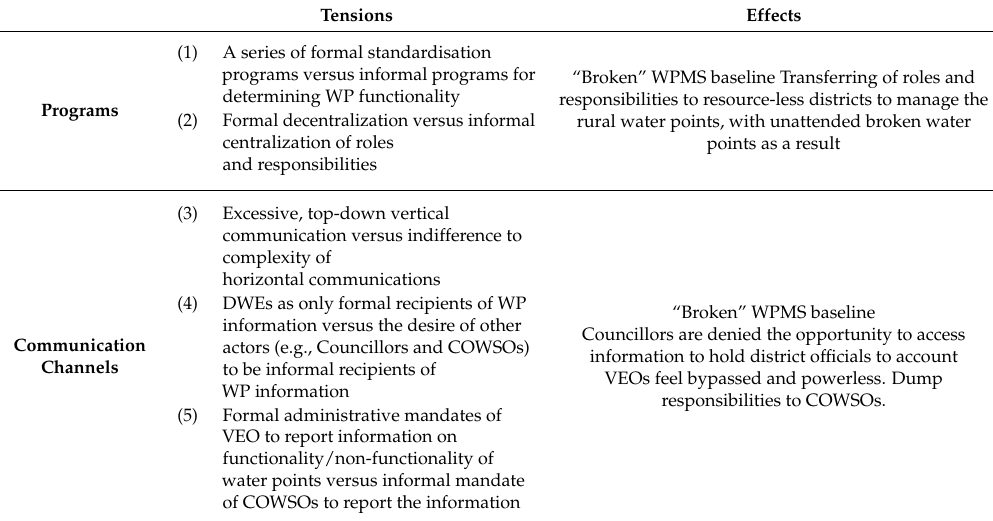
Table 4. Tensions between formal and informal programs and communication channels and their